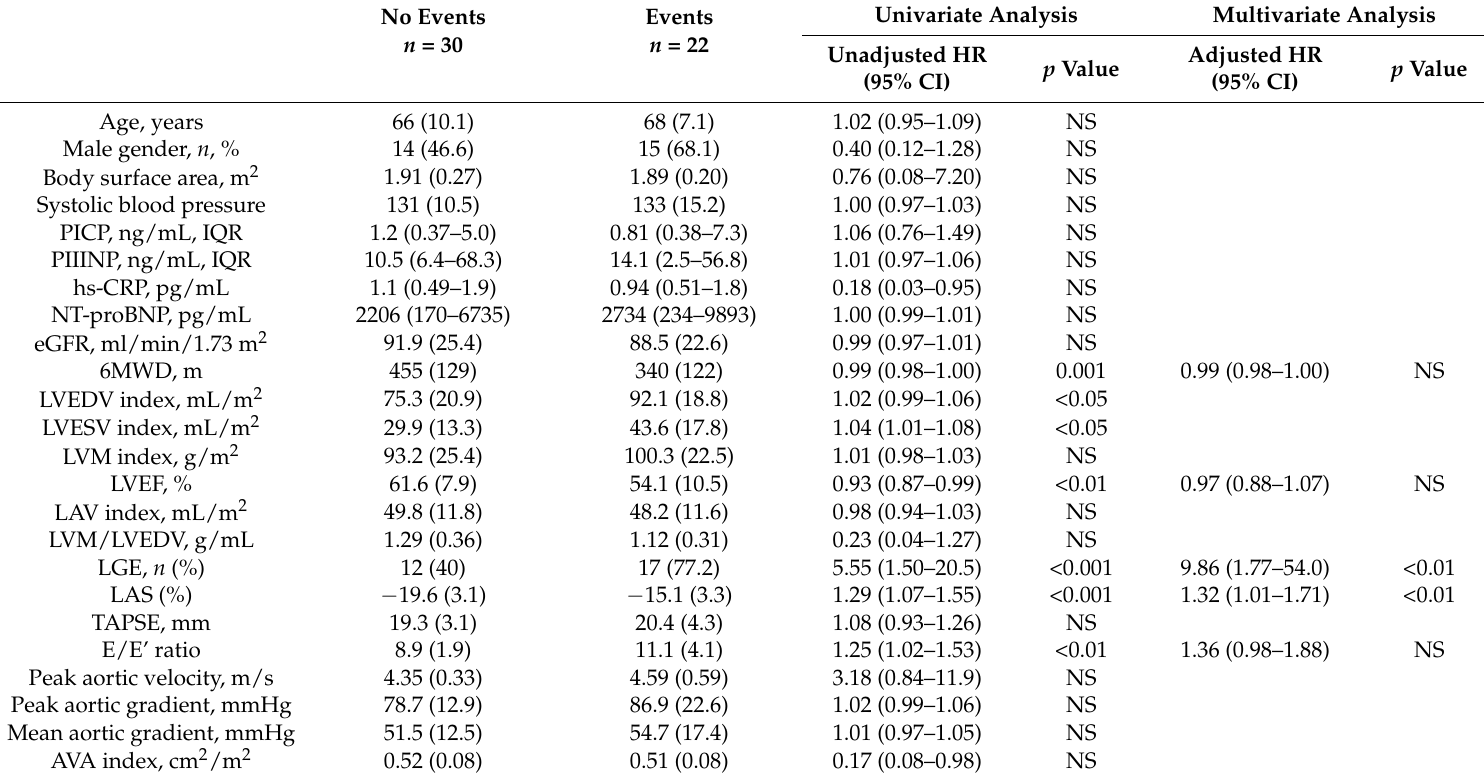
Table 4. Univariate and Multivariate Cox Analysis testing between studied parameters and major cardiovascular events (MACEs). Univariate Analysis Multivariate